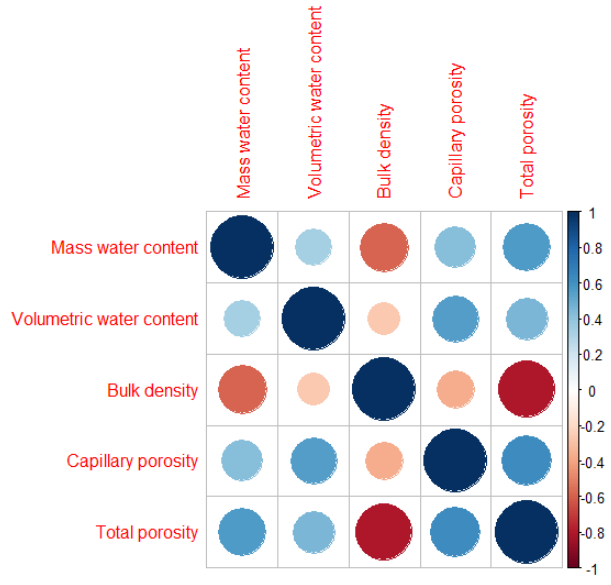
Figure 2. Spearman correlation for soil water parameters.